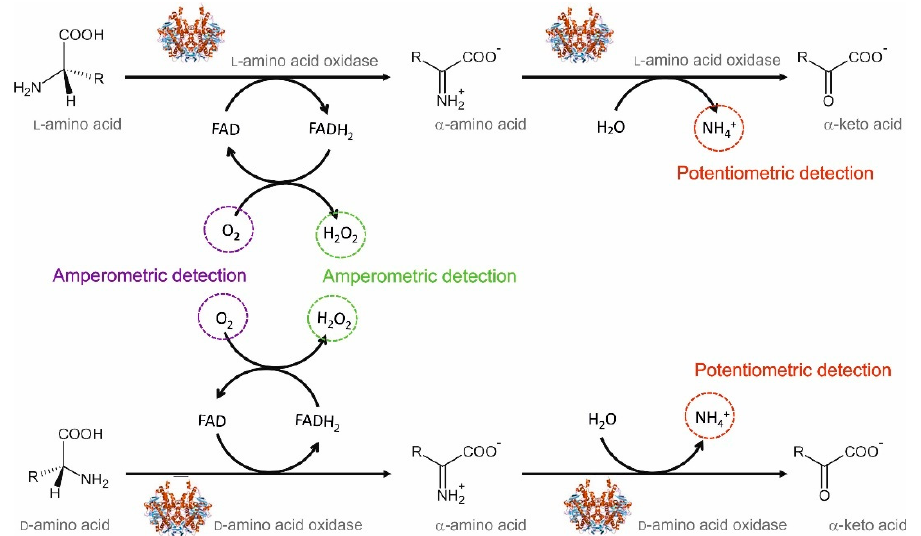
Figure 5. Main approaches for the biosensing determination of l -AAs (upper row) and d -AAs (lower row) based on electrochemical detection.